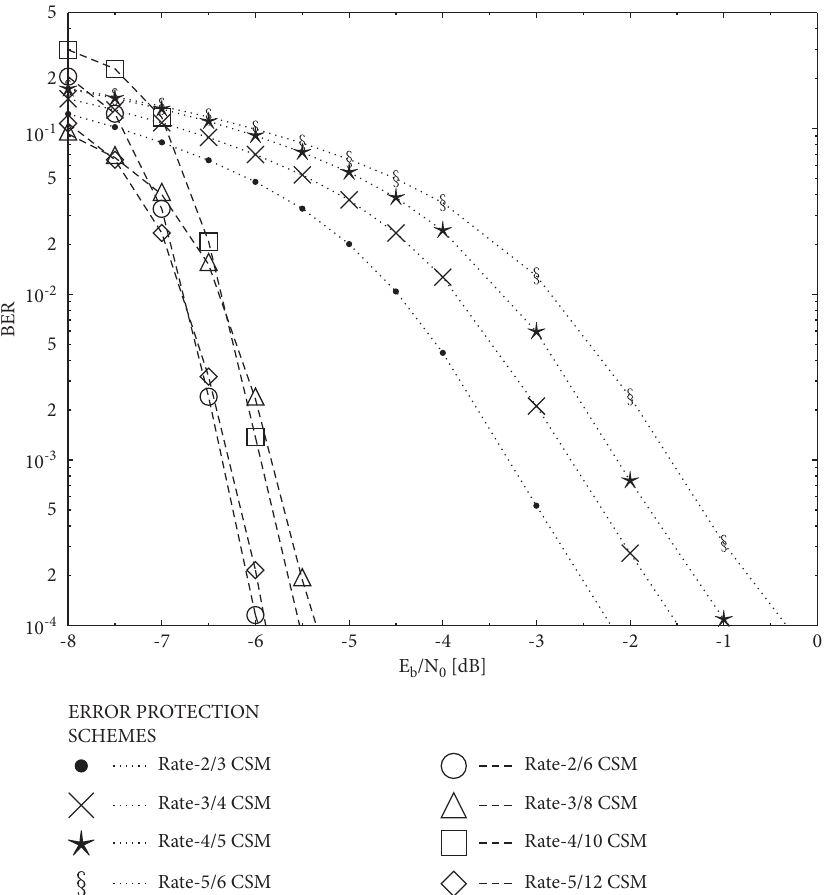
Figure 12: BER performance curves of CSM based schemes presented in Table